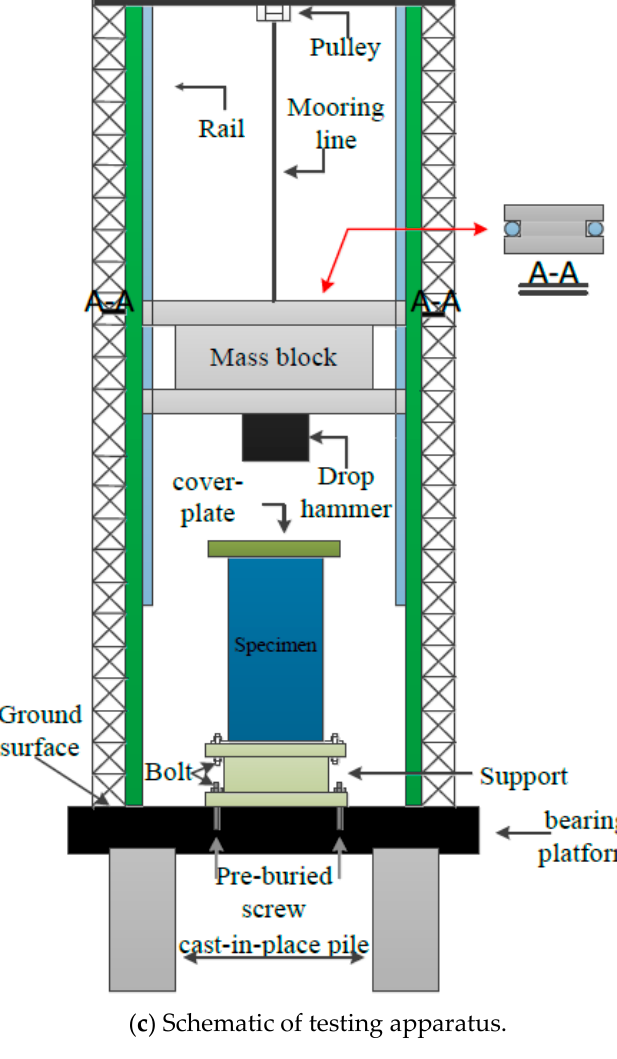
Figure 12. The impact test site.